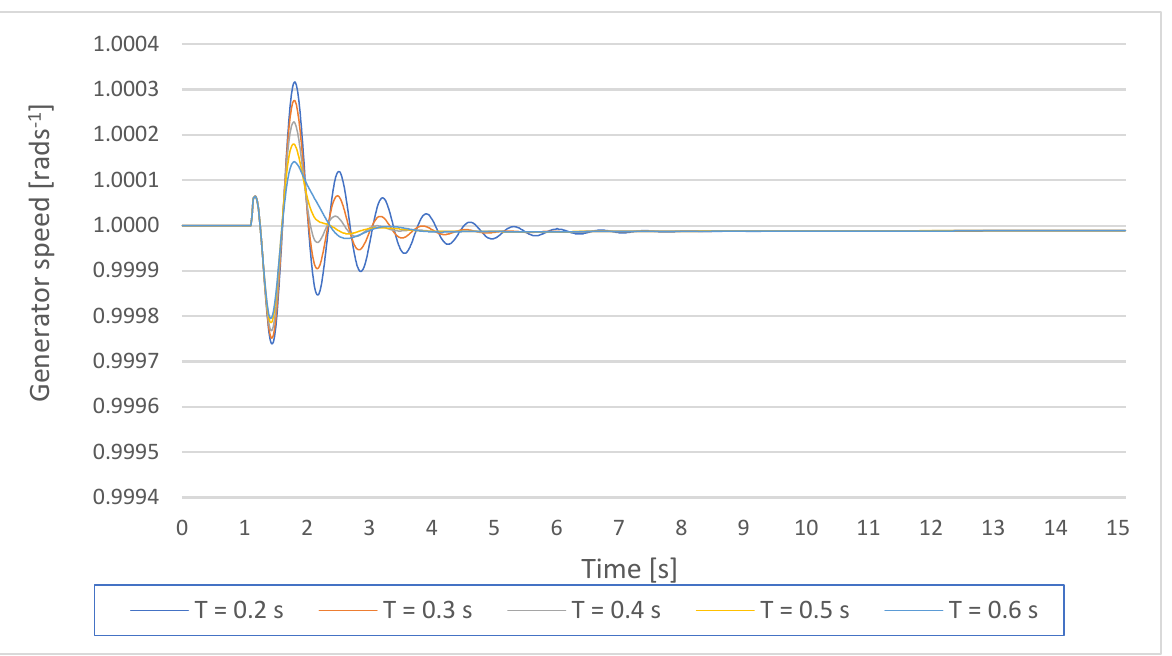
Figure 7. Gen1 rotor angle response on a small disturbance with PSS parameters K = 10, and T = Ti, 1 = 0.2–0.6 s.